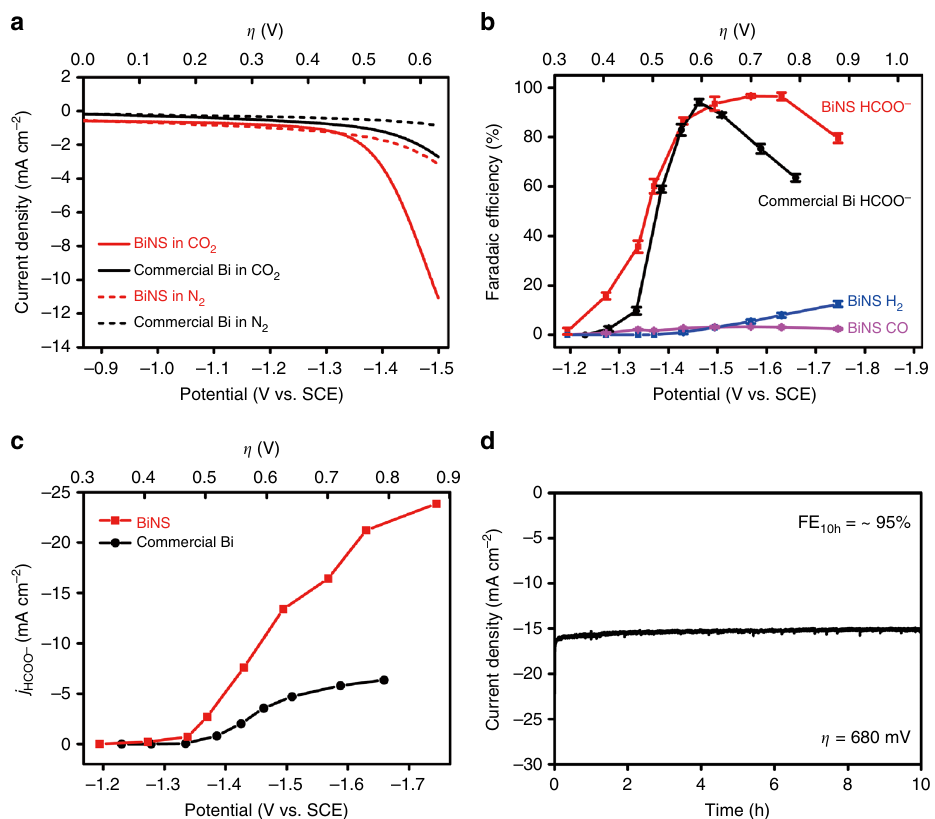
Fig. 3 Electrochemical measurements of BiNS. a Polarization curves of BiNS and commercial Bi nanopowder in N 2 - or CO 2 -saturated 0.5 M NaHCO 3 ; b potential-dependent Faradaic ef fi ciencies of HCOO − , CO, and H 2 on BiNS in comparison with the Faradaic ef fi ciency of HCOO − on commercial Bi nanopowder; c potential-dependent HCOO − partial current density on BiNS and commercial Bi nanopowder; d amperometric ( i ~ t ) stability of BiNS at η = 680 mV for 10